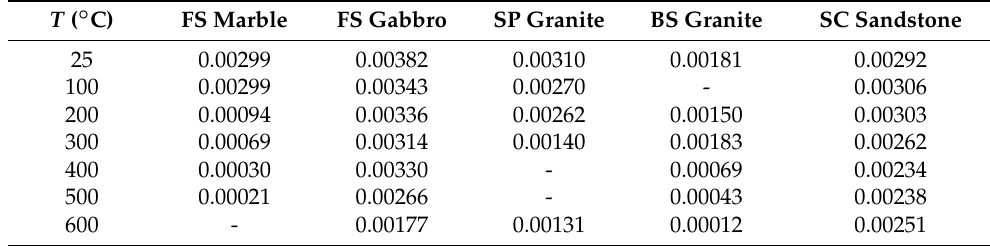
Table 4. The r IC value (m) for different processing